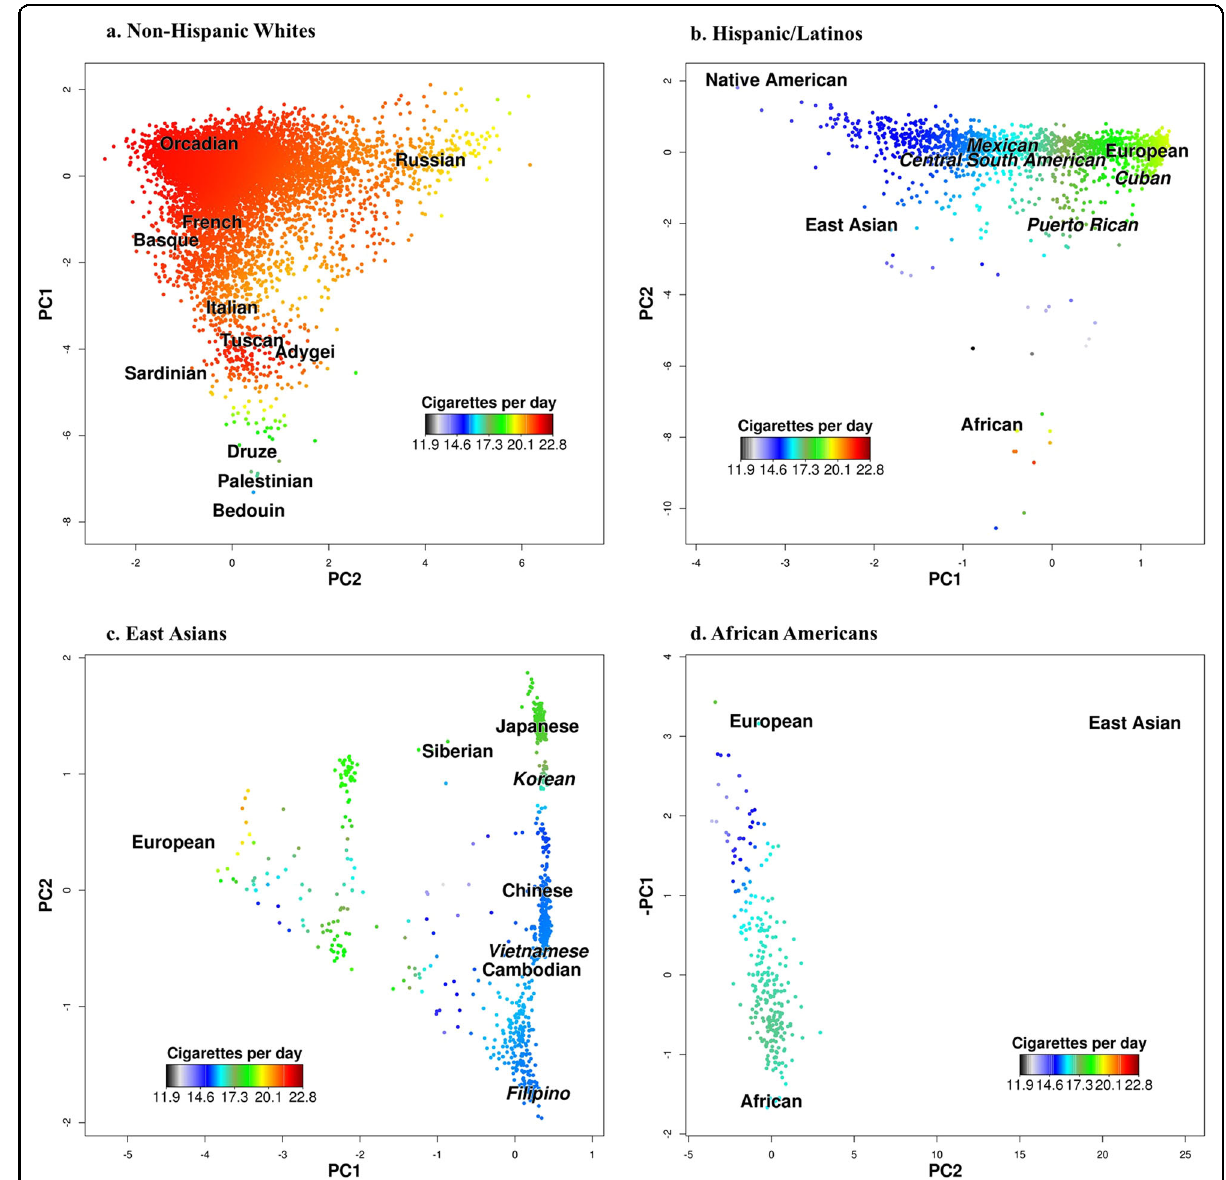
Fig. 2 Number of Cigarettes Smoked Per Day (CPD) Distribution vs. Genetic Ancestry. Plots of the number of CPD distribution vs. genetic ancestry in GERA: ( a ) non-Hispanic whites, ( b ) Hispanic/Latinos, ( c ) East Asians, and ( d ) African Americans. Human Genome Diversity Panel populations are plotted at their relative